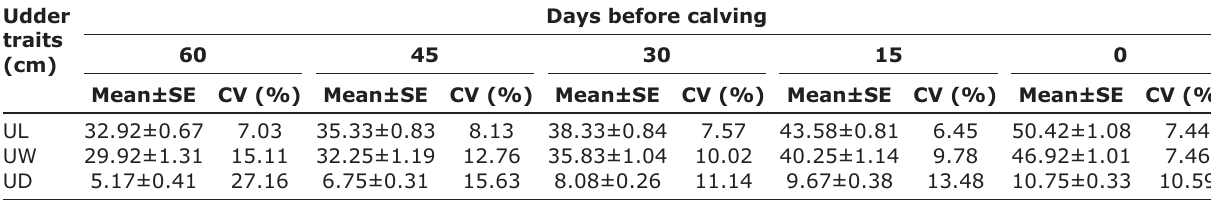
Table-1: Mean±SE and CV % of various udder traits in pregnant Nili-Ravi buffalo heifers. Udder traits (cm)